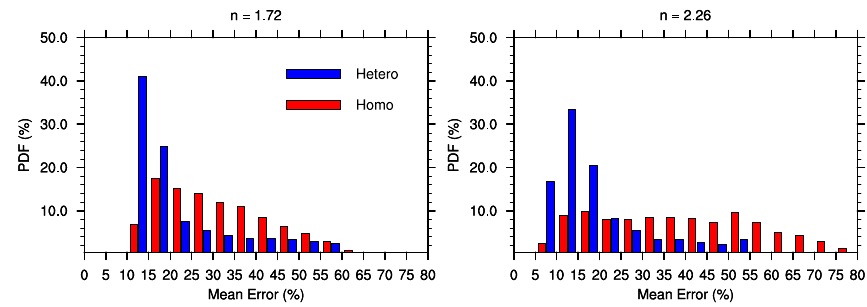
Figure 7. Probability density functions of the mean error for M3 ( n =1.72) and M4 ( n =2.26). The results for M3_Hetero and M4_Hetero are obtained with the optimized K sat,sf values used in Figs. 5 and 6, i.e., 2.1 × 10 − 5 ms − 1 and 1.9 × 10 − 5 ms − 1 ,